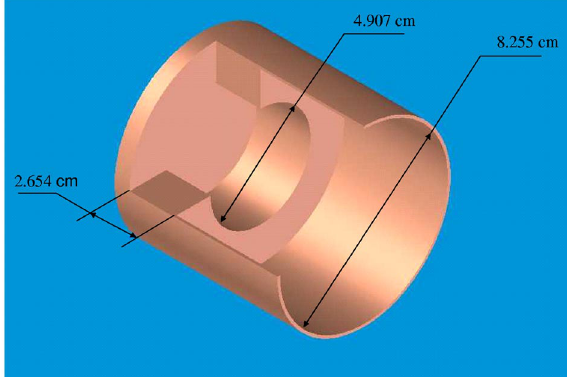
FIG. 2. (Color) TE - TE reflective mode converter. The di- 01 02 mensions shown are for an operating frequency of 11.424 GHz.